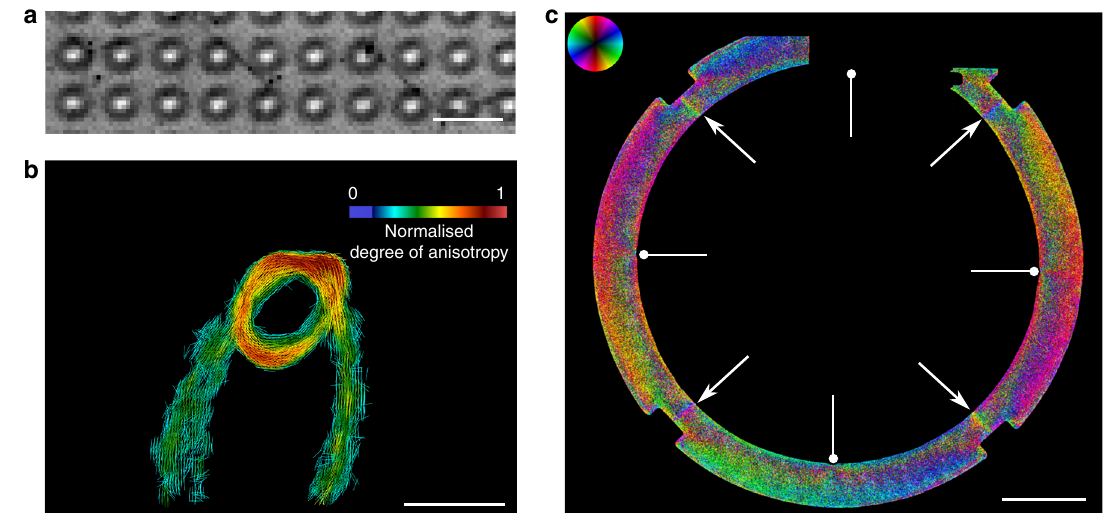
Fig. 5 Scattering imaging on polychromatic X-ray source. a Recorded intensity modulation on polychromatic X-ray source operated at 70 kVp with an average visibility of 20%. The scale bar corresponds to 260 μ m . b Proof of principal image of a carbon fi bre loop. The rendered lines represent the reconstructed direction of the underlying fi bres while the colour encodes the degree of anisotropy. The scale bar is 4 mm . c Reconstructed orientation map of an injection moulded carbon fi bre reinforced component. The pointy arrows correspond to the occurring weld lines while the rounded head arrows to the injection points. The scale bar is equal to 2